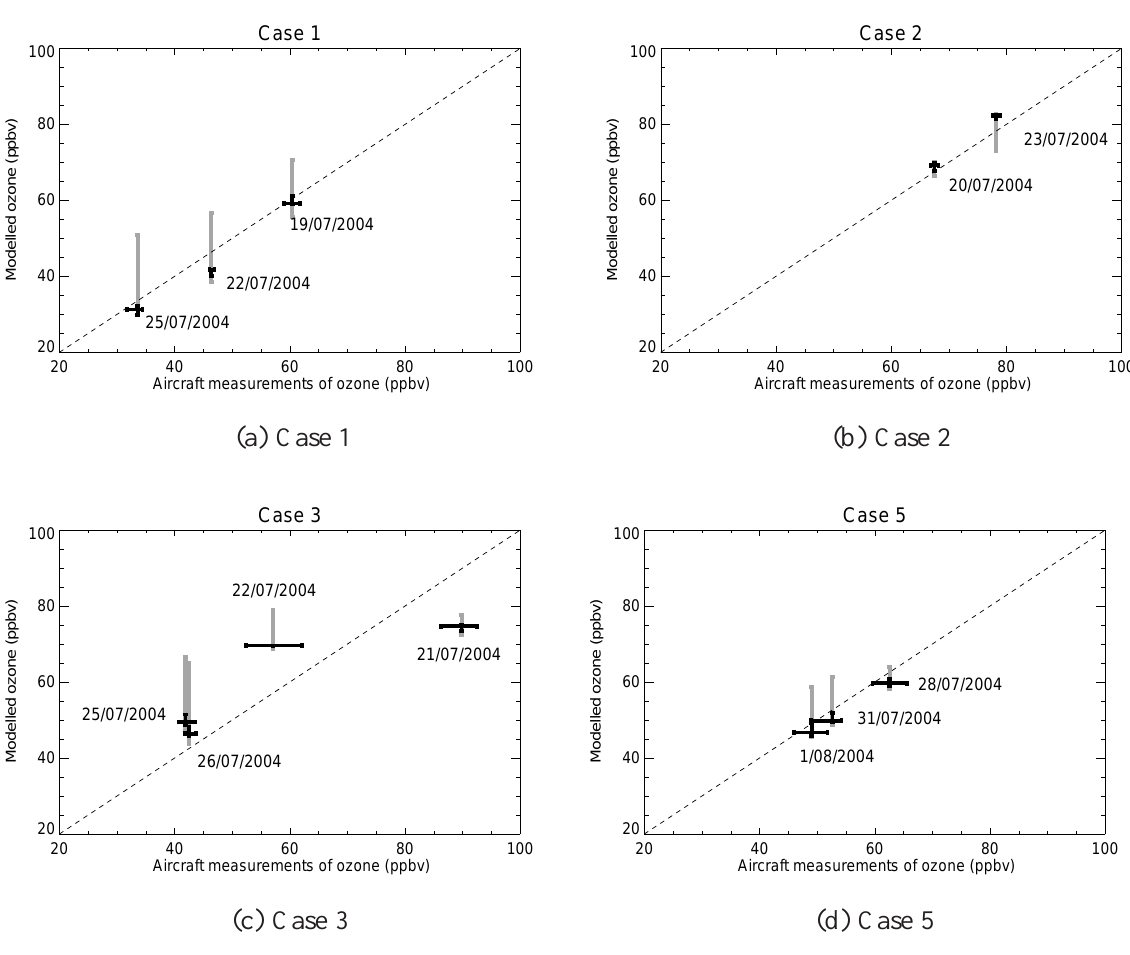
Fig. 7. Comparison of modelled and observed O 3 , as Fig. Fig. 7. Comparisonofmodelledandobserved O 3 ,asFig.6.